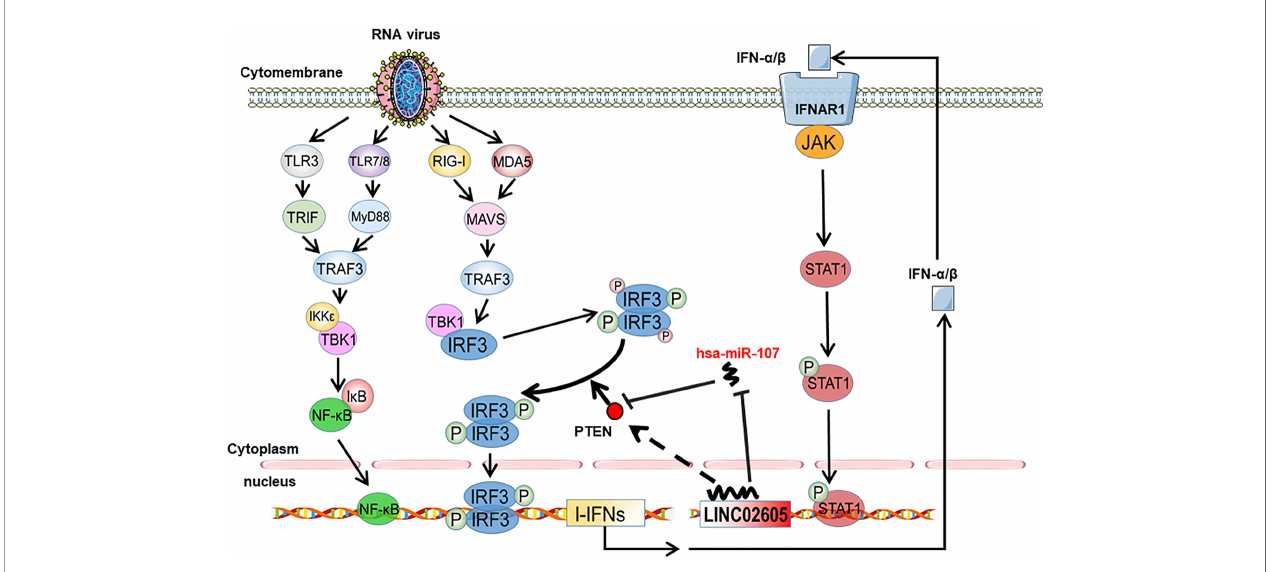
FIGURE 6 | Working model of type I interferon-inducible LINC02605 in innate immunity. It promotes type I interferon production in antiviral immunity by binding hsa- miR-107 to strengthen IRF3 signaling in a positive feedback